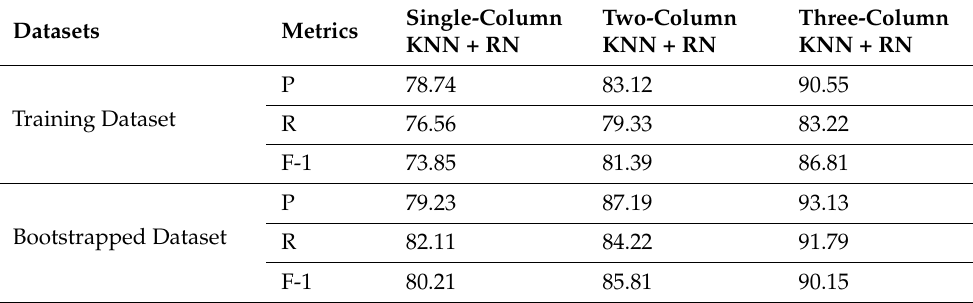
Table 5. Ablation study of the proposed